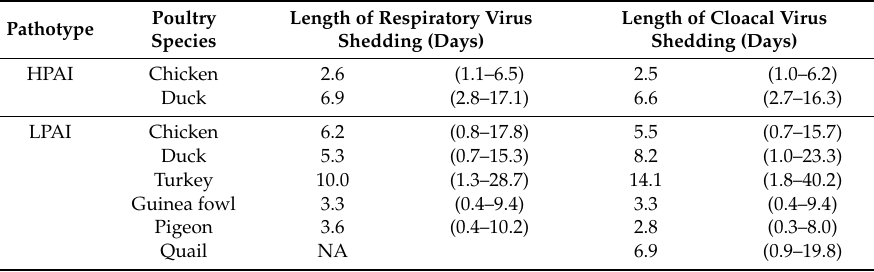
Table 4. An indication of AIV shedding length in days in multiple poultry species.